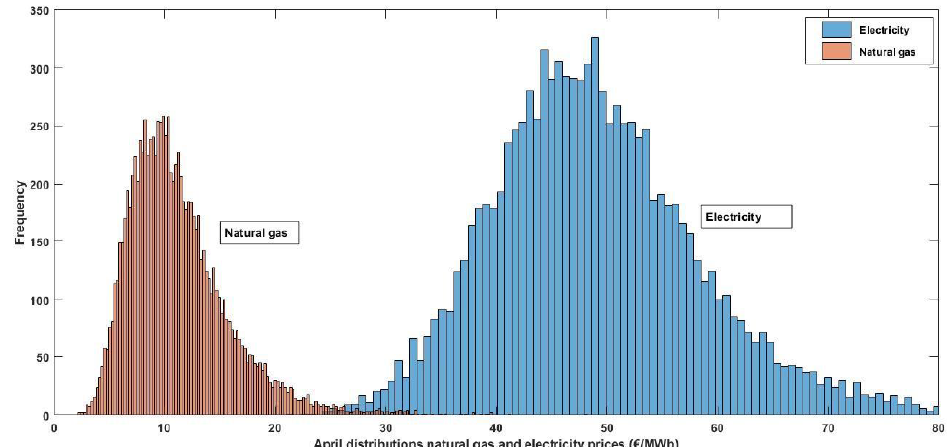
Figure 8. Histogram of monthly distributions of Spanish electricity and natural gas prices in April 2020 based on 10,000